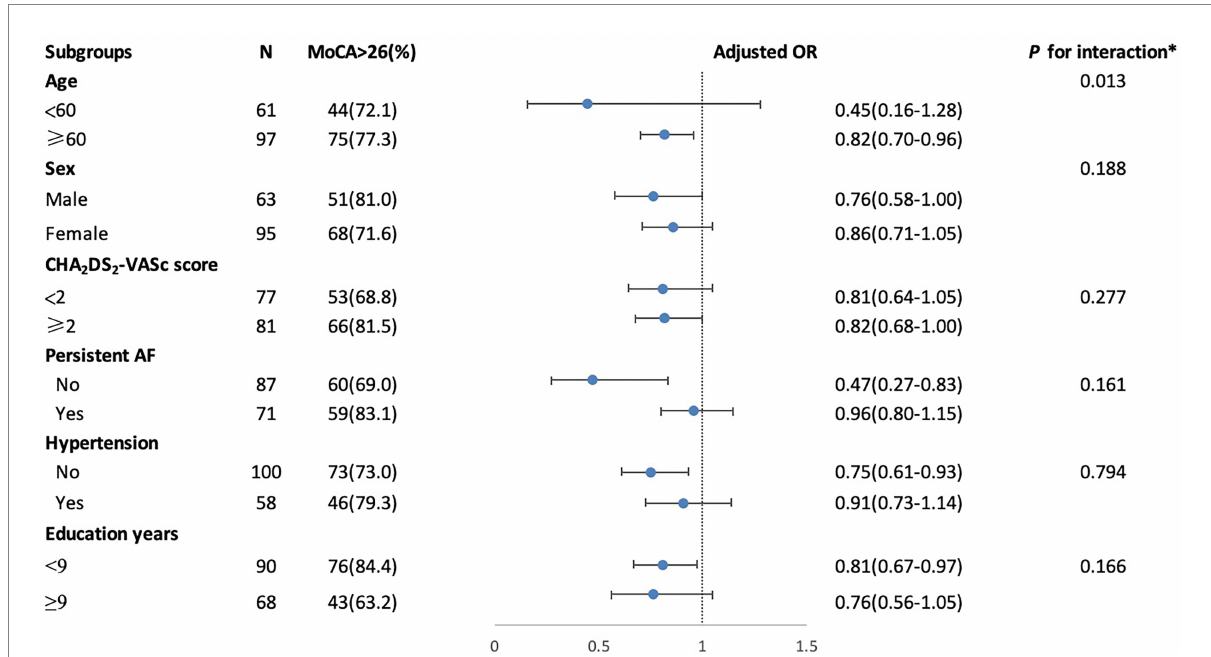
FIGURE 1 Stratified logistic regression analysis to identify variables modify the correlation between the presence of lacunes and MoCA. *Above model adjusted for age, sex, education years, hypertension, CHA2DS2-VASc score (congestive heart failure, hypertension, age ≥ 75 years, diabetes mellitus, stroke or transient ischemic attack (TIA), vascular disease, age 65 to 74 years, sex category) and persistent AF (atrial fibrillation). In each case, the model is not adjusted for the stratification